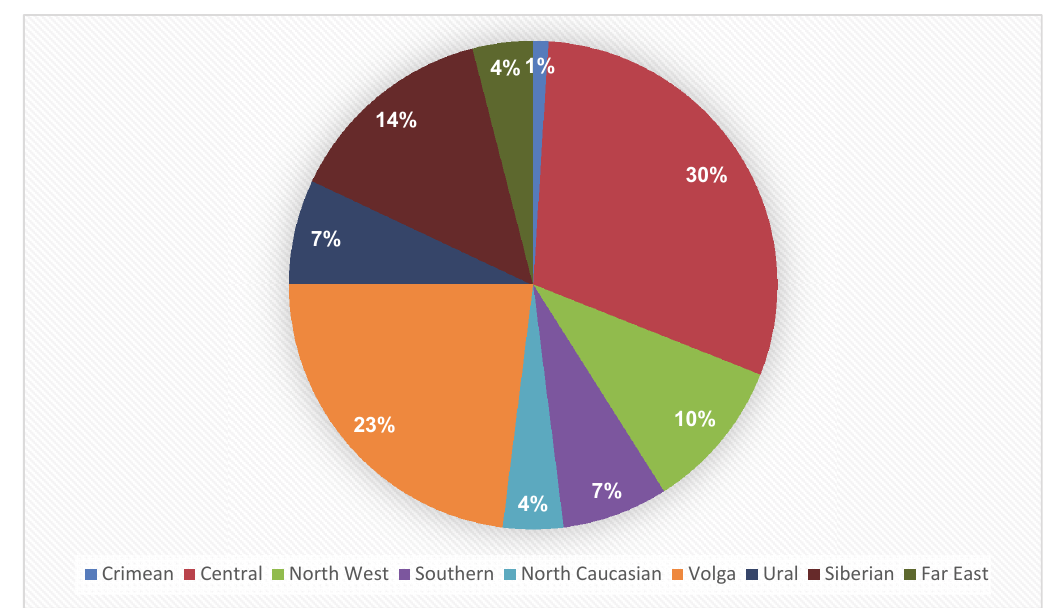
Fig. 1. Passenger transportation by federal districts in 2016, million